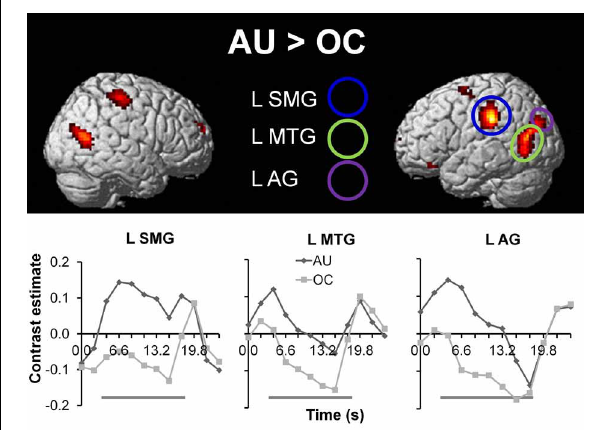
FIGURE 3 | Top: Whole brain results for the contrast AU > OC ( N = 43; p < 0 . 05, FDR corrected (voxel level), > 10 contiguous voxels). Below: Time series for the anatomically masked functional ROIs for the AU and OC conditions, with onset of instruction screen at time = 0s. The gray beams beneath the graphs represent object presentation (time = 3.0–18.0s) during which participants are required to generate solutions. Time series are presented for illustrative purposes only. AU, Alternative Uses; OC, Ordinary Characteristics; L SMG, left supramarginal gyrus; L MTG, left middle temporal gyrus; L AG, left angular